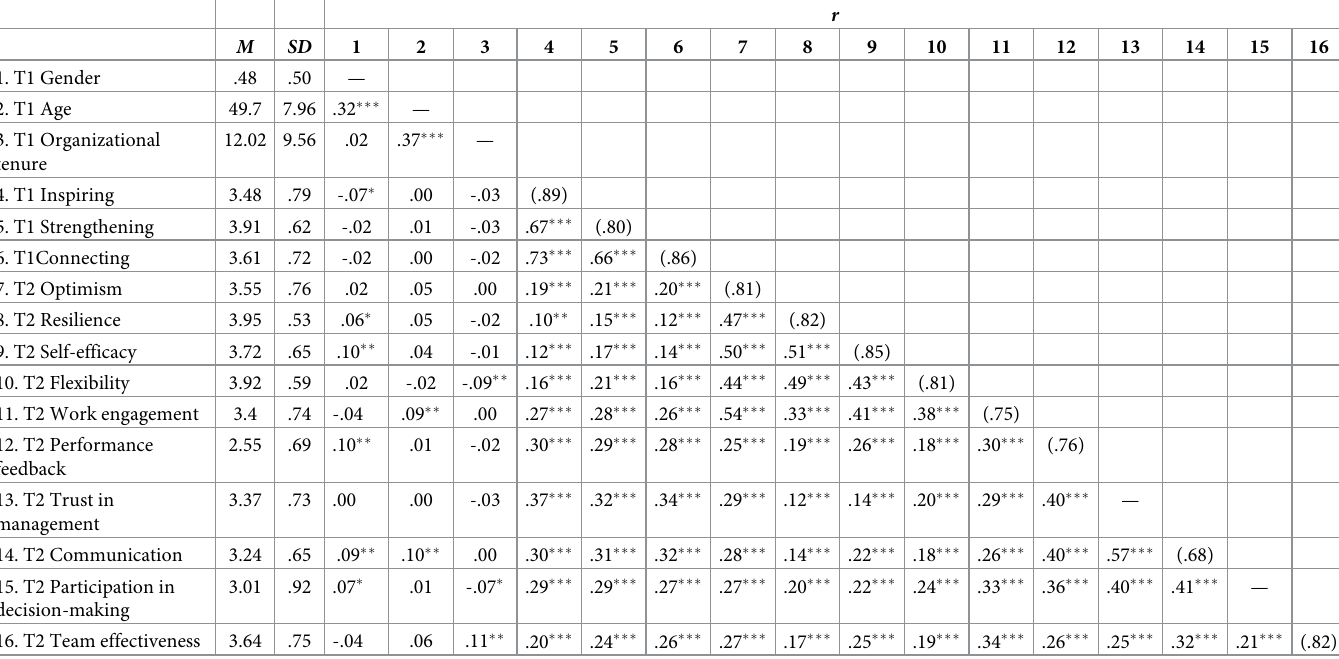
Table 2. Means, standard deviation, and zero-order correlations among the variables.